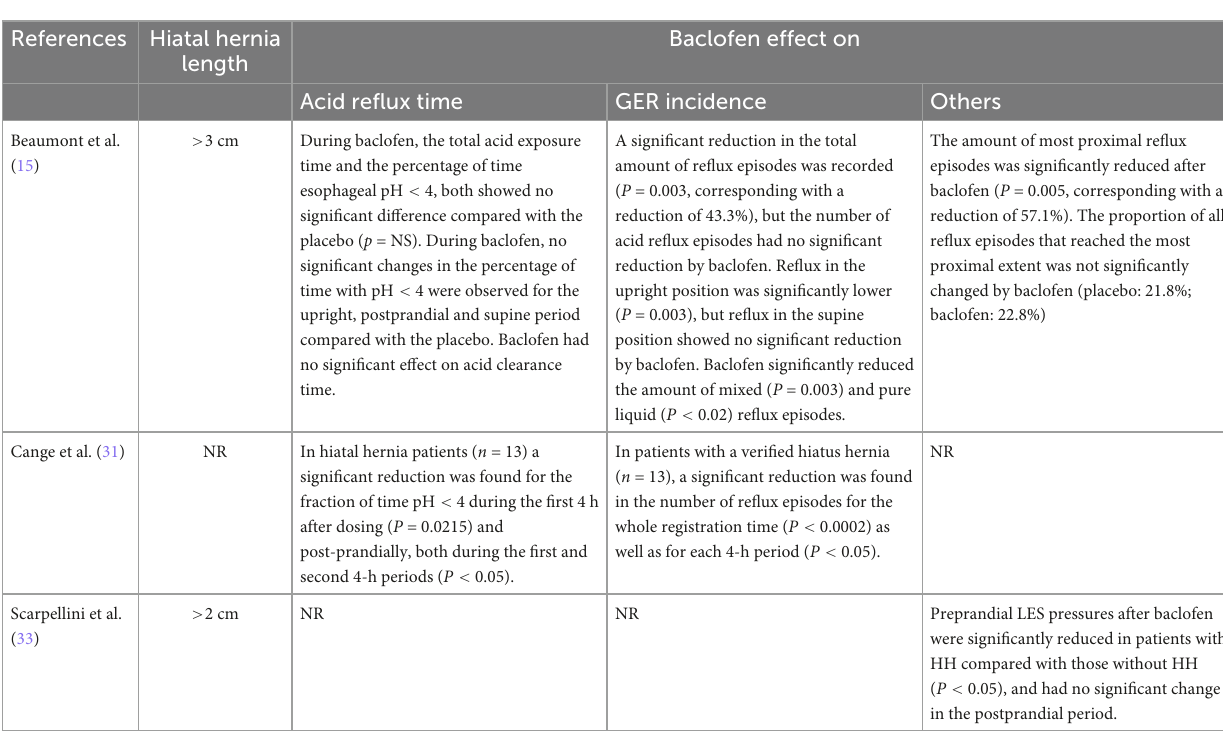
TABLE 8 Outcomes in patients with